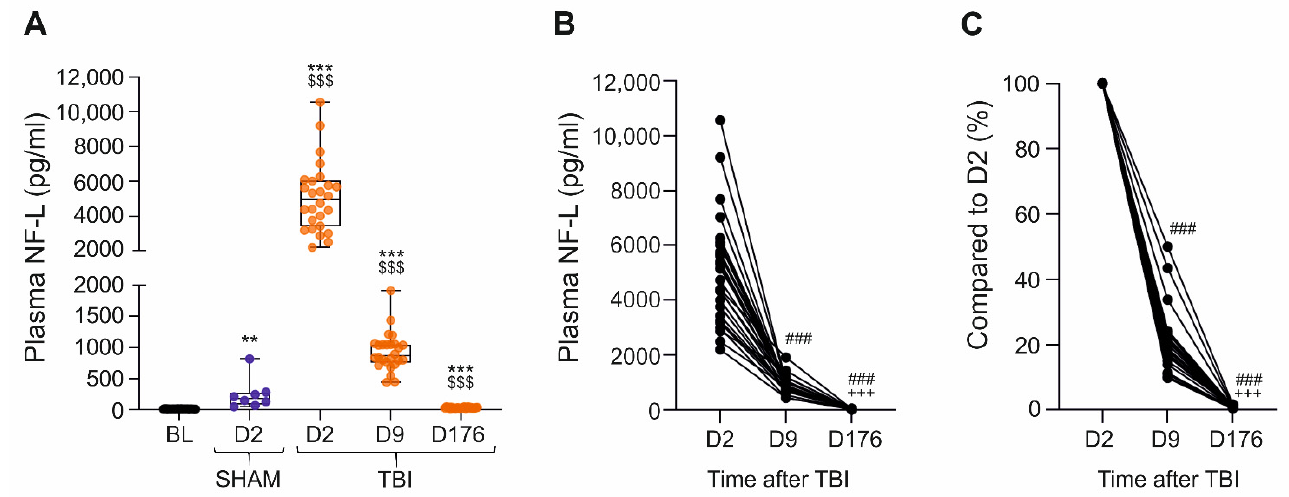
Figure 1. Plasma NF-L concentrations at different time-points after a sham operation or TBI. ( A ) Box and whisker plots (whiskers: minimum and maximum; box: interquartile range; line: median) showing plasma NF-L levels ( y -axis) in different groups ( x -axis). Samples collected at baseline (n = 34) before any operation (BL on D-6) were considered comparable to naïve samples. In the sham group (n = 8, blue), plasma NF-L levels were analyzed on D2 post-operation only. In the TBI group (n = 26, orange), plasma NF-L levels were assessed on D2, D9, and D176 after TBI. Each dot represents 1 animal. Note the slightly elevated plasma NF-L levels in the sham-operated animals on D2 compared with their baseline values (** p < 0.01, Wilcoxon). In the TBI group, the NF-L levels were elevated on all testing days as compared to their baseline values [Friedman test ( p < 0.001) followed by post hoc analysis with Wilcoxon: ***, p < 0.001]. On D2 and D9, the average NF-L levels were higher in the TBI group than in the sham group ($$$, p < 0.001, Mann-Whitney U test). ( B ) Dynamics of NF-L concentrations in individual TBI animals over time [Friedman test ( p < 0.001) followed by post hoc analysis with Wilcoxon: ###, p < 0.001 compared with D2; +++, p < 0.001 compared with D9]. ( C ) Change in plasma NF-L levels as a percentage over time (D2 marked as 100%) [Friedman test ( p < 0.001) followed by post hoc analysis with Wilcoxon: ###, p < 0.001 compared with D2; +++, p < 0.001 compared with D9]. Abbreviations: BL, baseline; D2, day 2 after TBI; D9, day 9; D176, day 176 (6 months); NF-L, neurofilament light chain; TBI, traumatic brain injury.